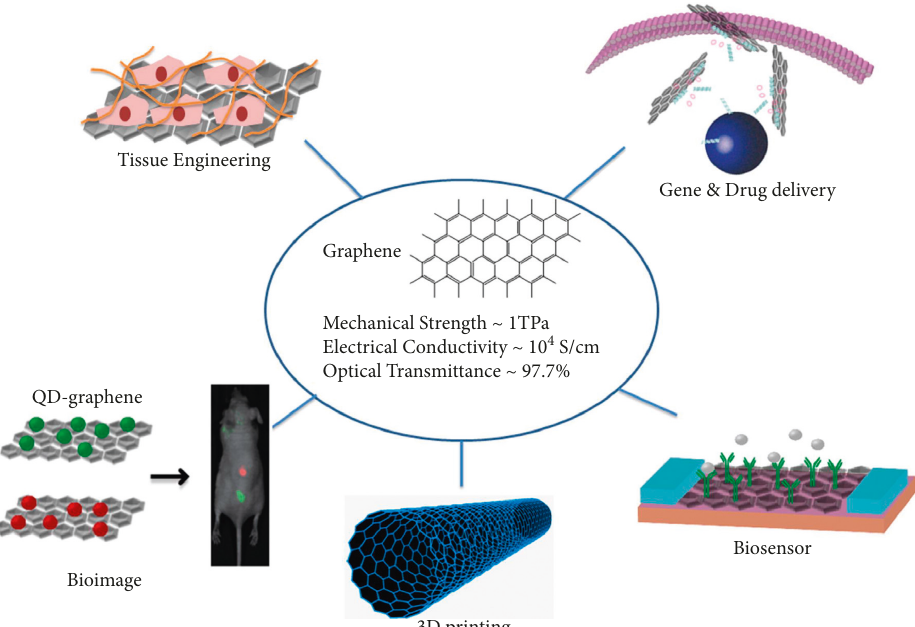
Figure 2: Overall application of graphene-based materials in regenerative medicine and tissue engineering [42]. Copyright 2016, with permission from